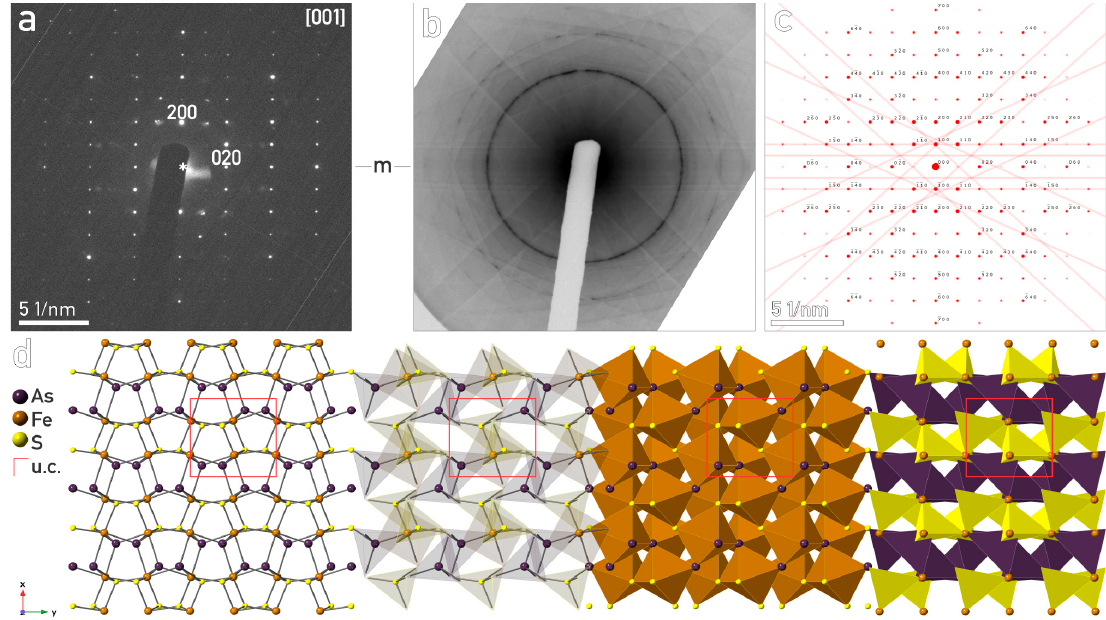
Figure 4. ( a ) SAED pattern indexed for arsenopyrite, with the corresponding ( b ) CBED pattern showing Kikuchi lines. ( c ) Simulated SAED and CBED (threshold 55%, intensity factor 1%, squares are space group absences). ( d ) Arsenopyrite crystal structure in the same orientation left to right: ball–stick model, coordination tetrahedra model, Fe-tetrahedra, and As- and S-tetrahedra models. The red square indicates the unit cell (u.c.).